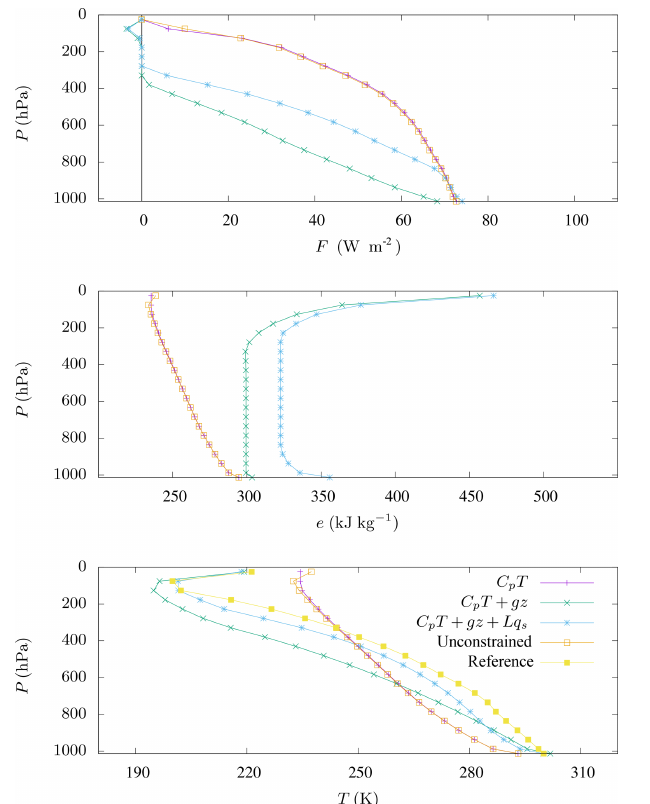
Figure 3. Energy flux F , specific energy e , and temperature T for tropical atmospheric composition measured by McClatchey et al. (1972) and different expressions for energy on the constraint ( e = C p T , e = C p T + gz , and e = C p T + gz + Lq s ). The elevation is given in pressure level P . Results for the unconstrained model of Herbert et al. (2013) are represented. We also give the tempera- ture profile corresponding to the measurements of McClatchey et al. (1972), labelled as “reference” for qualitative